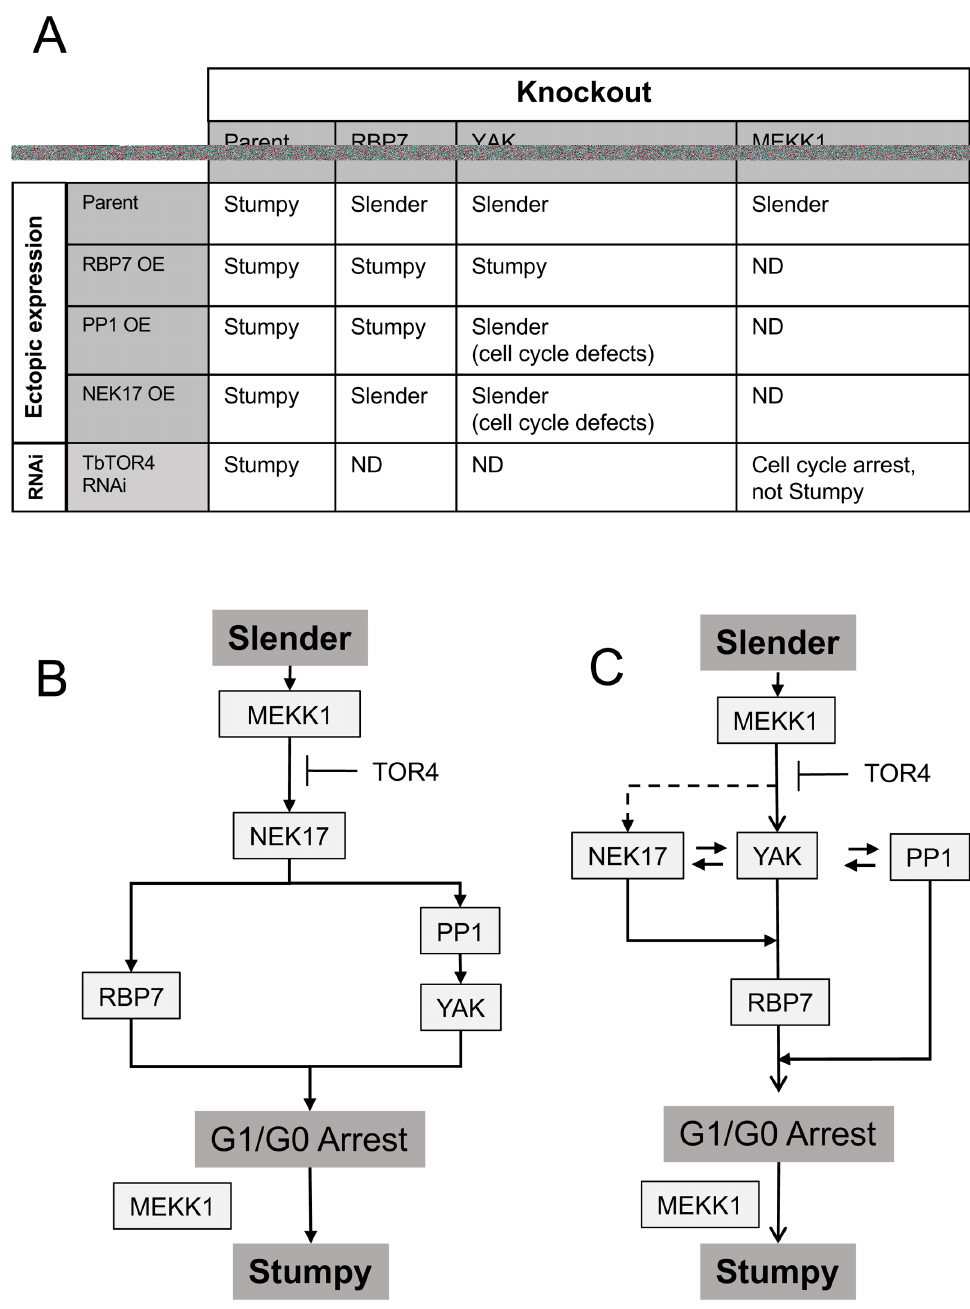
Fig 10. Pathway models and dependency relationships for the interactions studied in this work. A. A summary of the ectopic expression and gene knockout or RNAi combinations used in this study. B. In this model, the pathway is branched but neither branch is redundant. C. In this model, the pathway is unbranched but the presence of YAK is necessary for PP1-6 to generate stumpy forms when expressed. RBP7 is required for the NEK17 expression induced growth phenotype; in YAK null mutants NEK17 expression generates slow growth. MEKK1 is needed for cell cycle arrest, although this can be overcome when TbTOR4 is depleted. However, MEKK1 is needed for the effective development of stumpy forms in TbTOR4 arrested cells. The dotted line indicates the potential for MEKK1 to directly or indirectly phosphorylate NEK17 as determined by phosphoproteomic analysis.